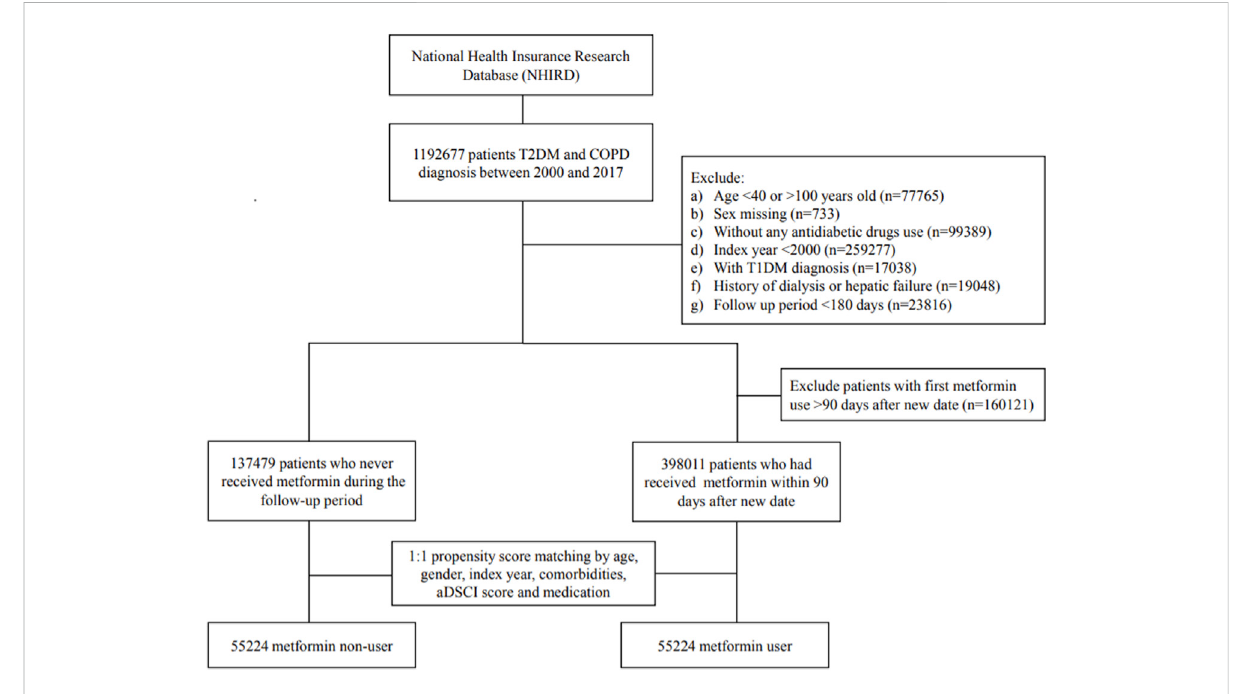
FIGURE 1 Flow diagram of the recruitment process.